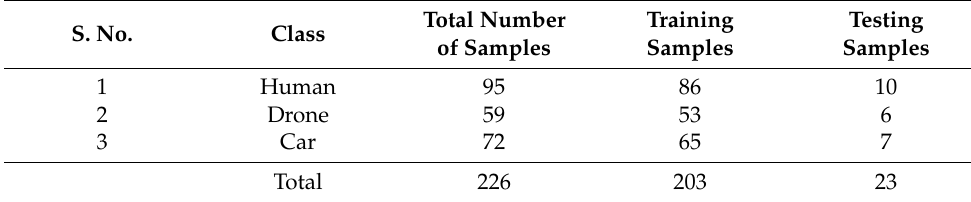
Table 2. Per class total samples, train samples, and test samples count S.